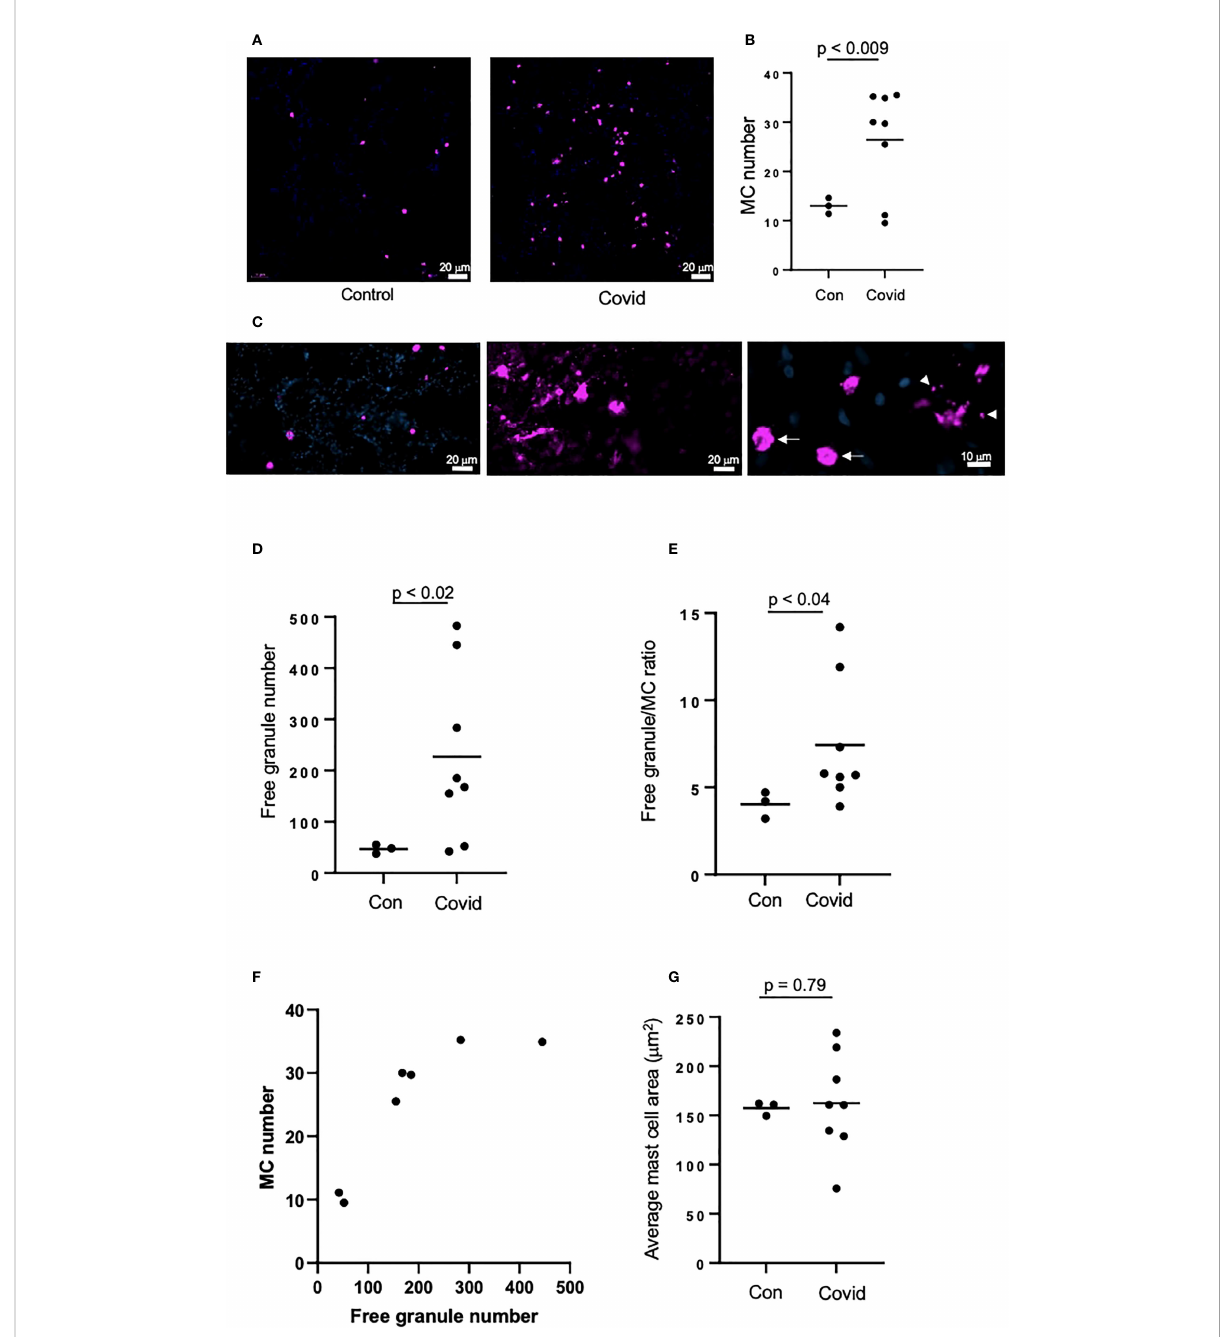
FIGURE 2 MC recruitment and degranulation is increased in the lungs of patients post-SARS-CoV-2 infection. The lungs of patients deceased post-SARS- CoV-2 infection were frozen, sectioned to 6 m m and labelled by immuno fl uorescence, before imaging using an epi fl uorescence microscope. Lungs of non-SARS-CoV-2-linked deaths were used as a control. (A) MCs were identi fi ed by tryptase (magenta) in the lungs of deceased non- SARS-CoV-2 (n=3) or COVID-19 patients (n=8); (B) Quanti fi cation of MC numbers; (C) Non-degranulated (controls, left panel) and degranulated (COVID-19, middle panel) MCs; right panel represents non-degranulated MC (arrows) and granules (arrowheads) releasing from a MC in the process of degranulation; (D) Quanti fi cation of MC granules identi fi ed as tryptase-positive objects with the area of <50 µm 2 ; (E) Ratio between the numbers of cell-free granules and MCs; (F) Correlation between the numbers of MCs and cell-free granules; (G) Quanti fi cation of the average of MC area. Images were analyzed using ImageJ. Horizontal lines represent mean. Statistical signi fi cance was determined using the unpaired Student ’ s